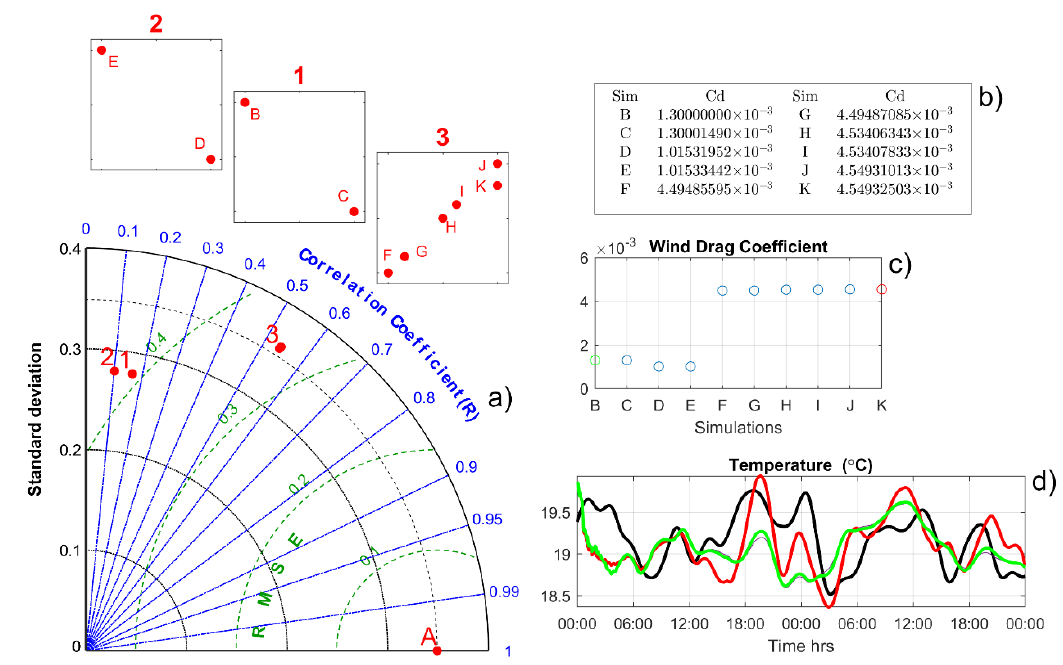
Figure 14. Calibration of the model based on the optimization of the wind drag coefficient (C d ) considering the temperature field. ( a ) Taylor diagram with three groups of several simulations. In this diagram, the red A represents the observational data; the other letters represent the 10 simulations; group 1 [B, C], group 2 [D, E], and group 3 [F to K]; a close-up of the Taylor diagram is shown in the inset upper boxes. In ( b ), the numerical values of the optimization process. In ( c ), the optimization procedure from typical (green circle) to the best parameter (red circle). In ( d ), the time series shown in black is registered by the thermistor located at 18 m during June 2018. The simulation run using the typical value for lakes (C d = 1.3 × 10 −3 ) is in green, and the optimal wind stress coefficient (C d = 4.5 × 10 −3 ) is in red.